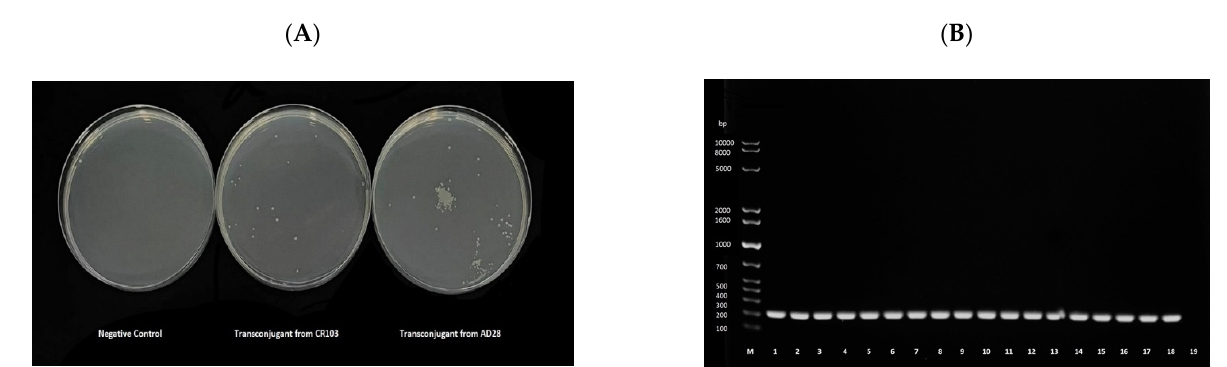
( B ) Figure 2. ( A ) Representative image of the One Shot TM OmniMAXTM 2 T1R E. coli growth in Muller– Hinton media supplemented with 4 μ g/mL of colistin following heat-shock transformation. The negative control underwent the heat-shock method without adding plasmid. ( B ) Agarose gel elec- trophoresis of the mcr-1 PCR product from DNA extracts of the transformants. The first well, la- belled M, contained a 1 kb Ladder. Plasmids extracted from each sample were transformed into a chemically competent E. coli. The origin of the DNA in each well were as follows, 1: ad28, 2: ad80, 3: ad107, 4: ad108, 5: ad174, 6: ar181, 7: ar182, 8: br128, 9: br129, 10: cd62, 11: cd63, 12: cr102, 13: cr103, 14: FC1, 15: FC4, 16: FC6, 17: FC7, 18: FC12, 19: PCR negative control. 2.4. Trasnmissibility of the mcr-1 via Conjugation